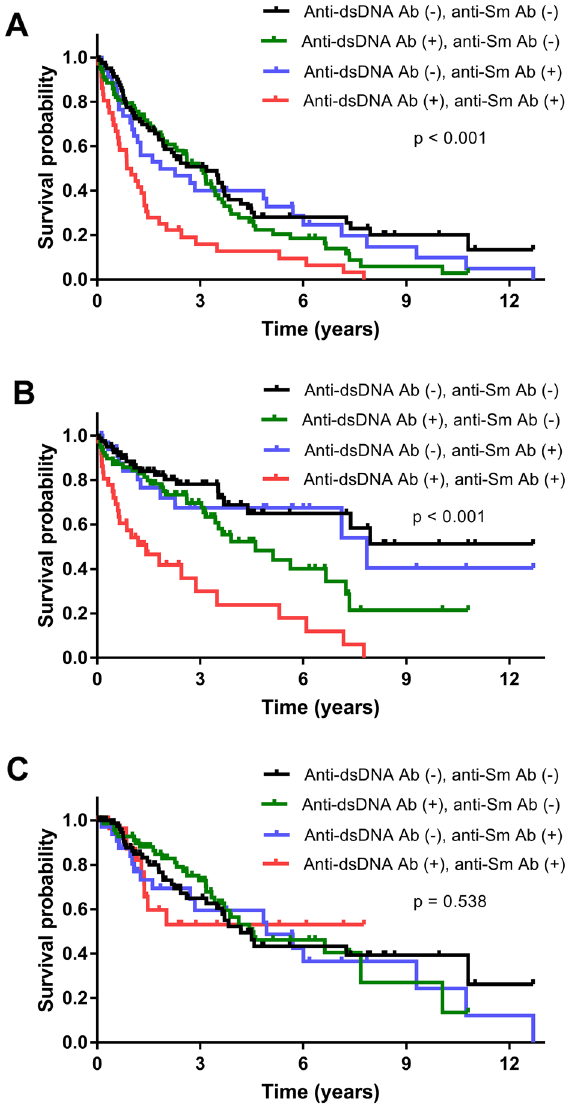
Figure 1. Flare-free survival curves according to the four levels of positivity for anti-dsDNA and anti-Sm Abs. ( A ) any flares, ( B ) severe flares, and ( C ) mild-to-moderate flares. ds—double-stranded;